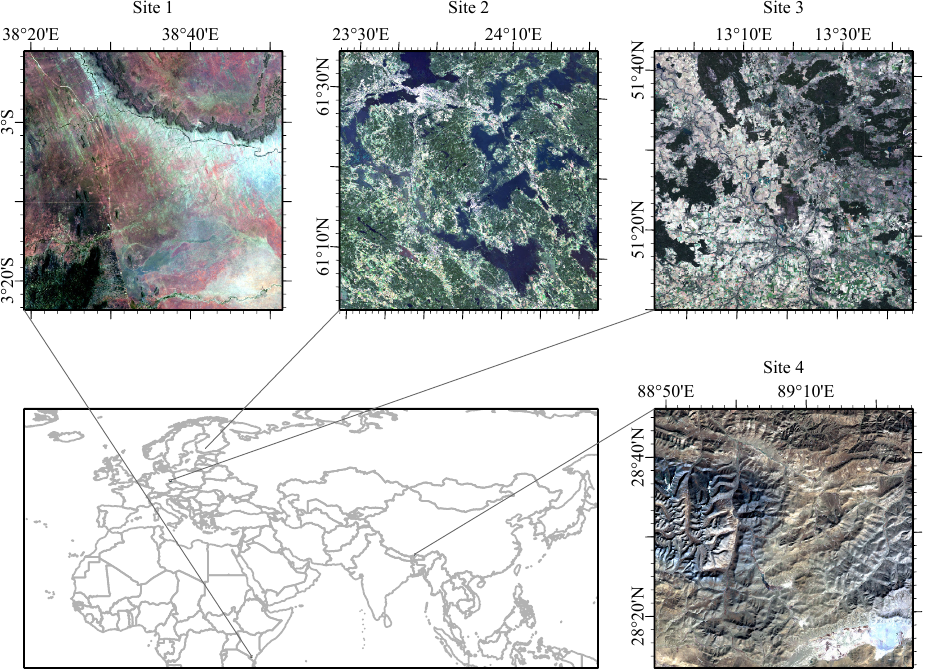
Figure 1. Location of the study areas. Site 1: Taita Taveta County, Kenya; Site 2: Pirkanmaa province, Finland; Site 3: Brandenburg, Germany; and Site 4: Qinghai-Tibet Plateau, China.